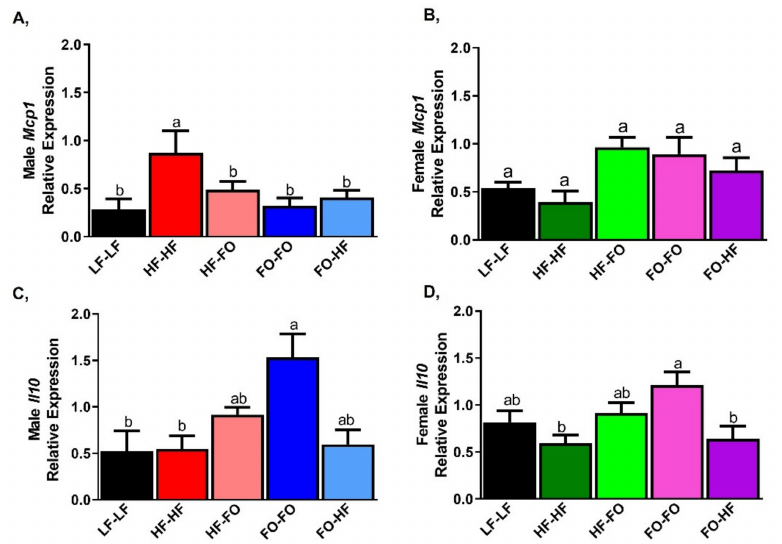
Figure 10. Fish oil supplementation reduces pro-inflammatory markers in Liver of mice: ( A , B ) mRNA levels of pro-inflammatory marker monocyte chemoattractant protein ( Mcp1 ) in liver of male and female mice. ( C , D ) mRNA levels of interleukin 10 ( Il10 ) in male and female mice. Data is presented as mean ± SEM (n = 8). Common letters on the error bars indicate no significance (e.g., “a” is significantly different from “b” and “ab” indicates no significance compared to “a” and “b”).